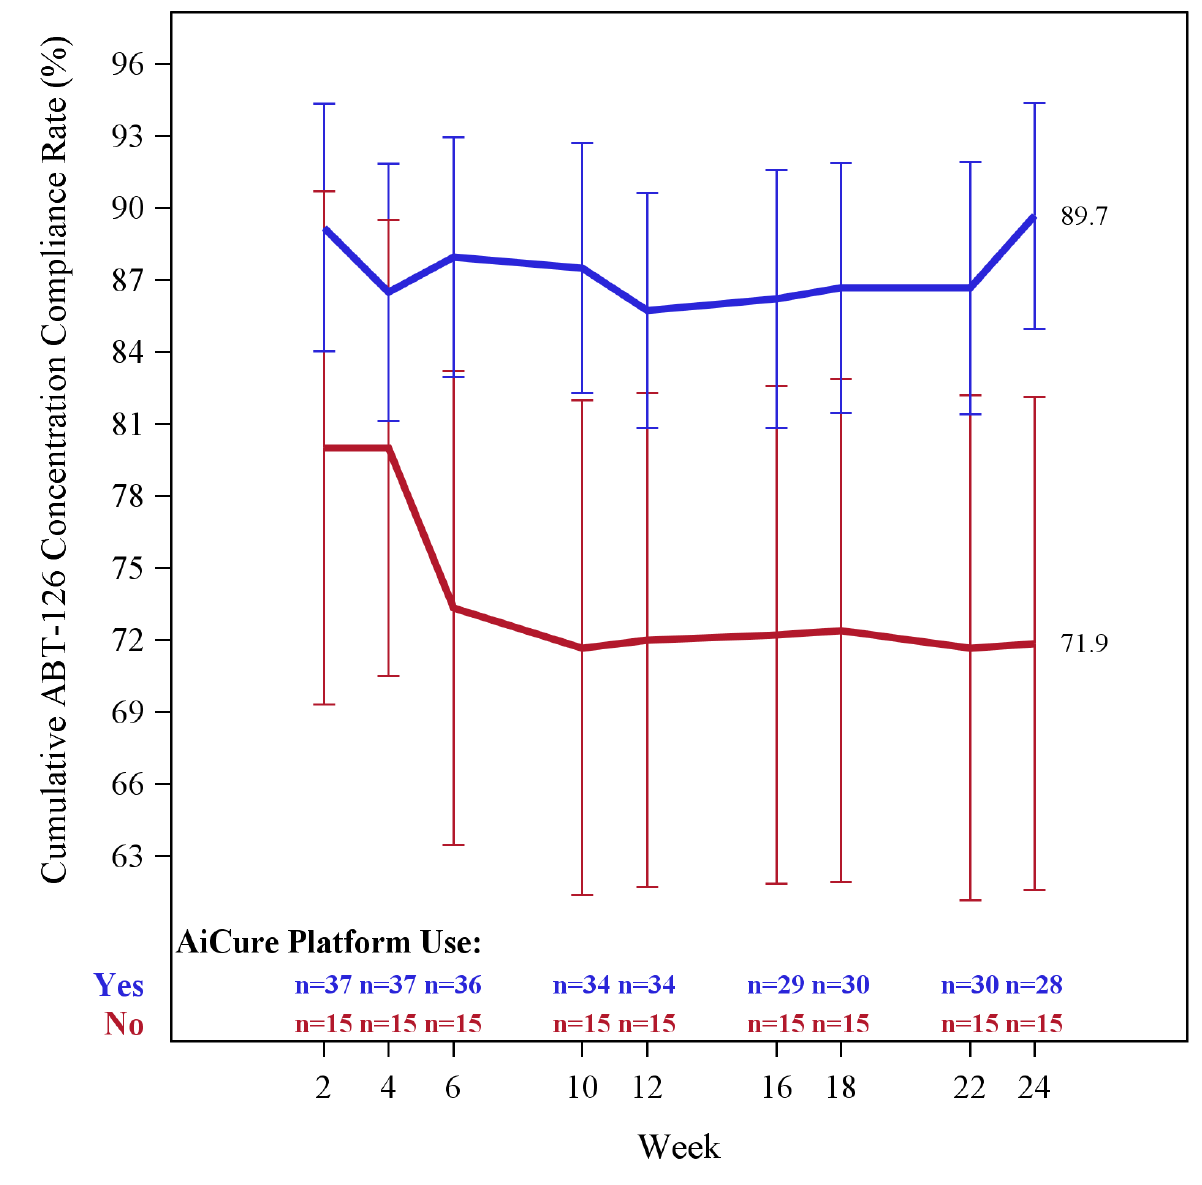
Figure 3. Cumulative adherence based on study drug (ABT-126)